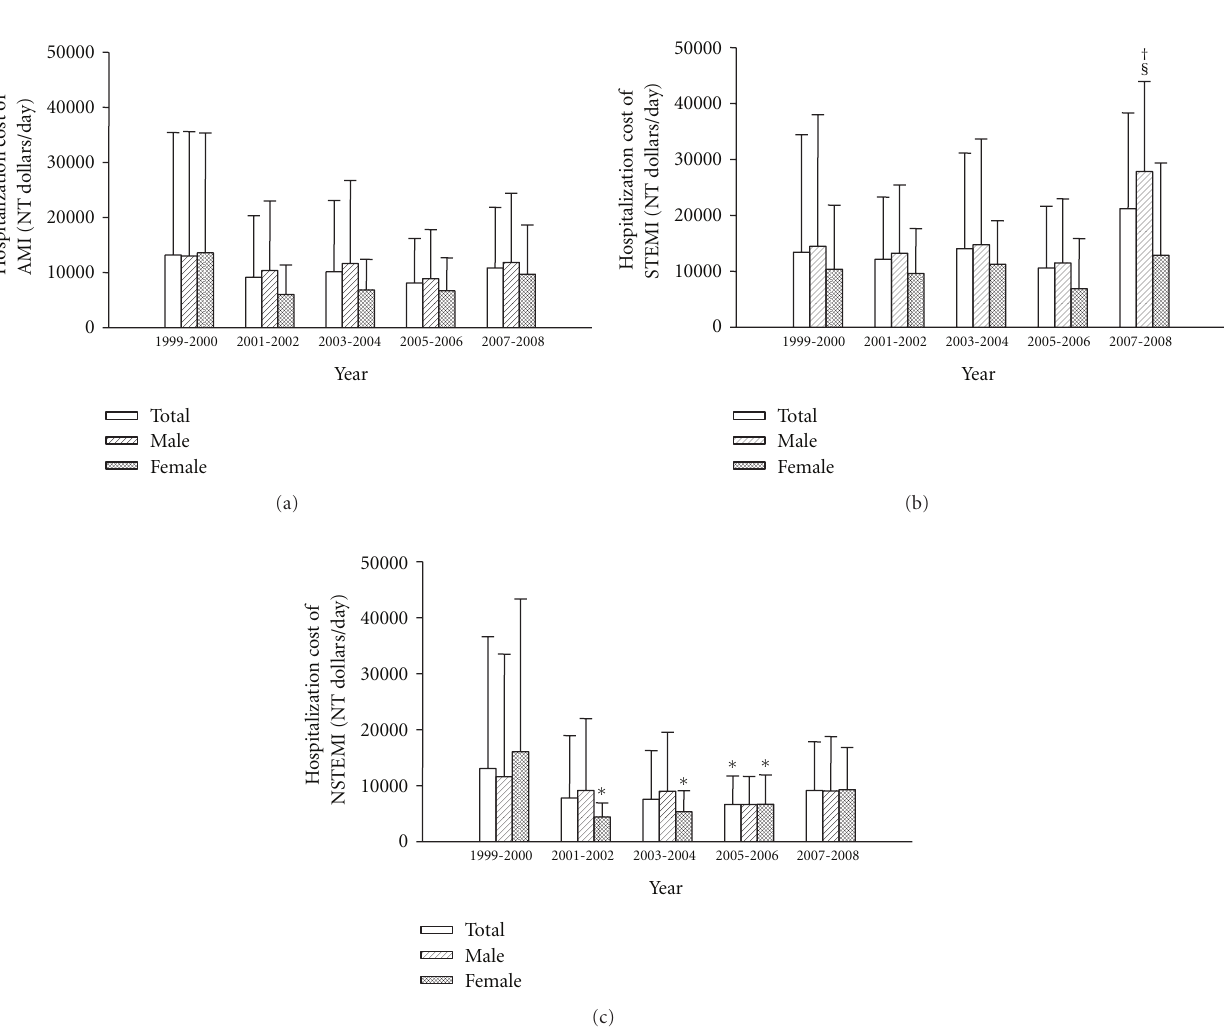
caused by the gender di ff erences because the hospitalization percentages of AMI and STEMI were lower in female than in male. Moreover, typical symptoms of coronary artery diseases or more attention and aggressive prevention in male gender may potentially result in the decline in MI or STEMI.